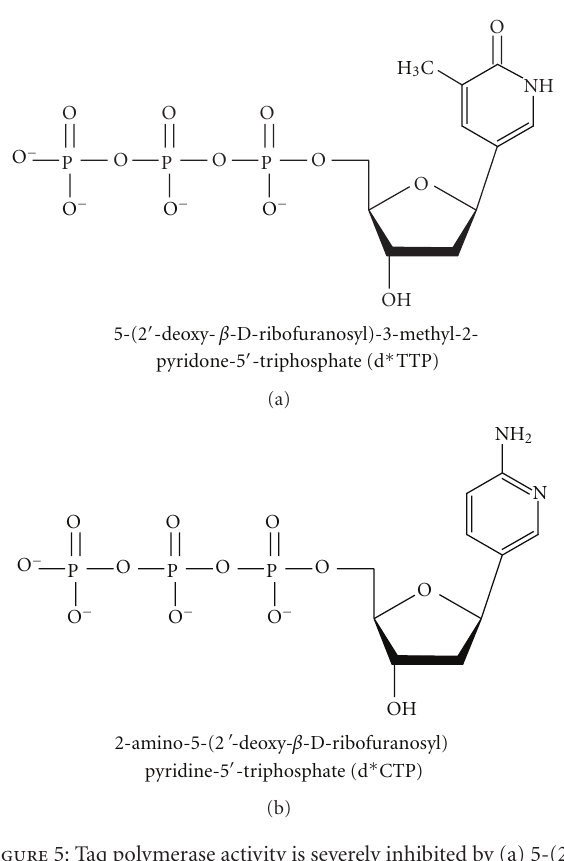
Figure 5: Taq polymerase activity is severely inhibited by (a) 5-(2 (cid:2) - Deoxy- β - D -ribofuranosyl)-3-methyl-2-pyridone-5 (cid:2) -triphosphate d ∗ TTP and (b) 2-Amino-5-(2 (cid:2) -deoxy- β - D -ribofuranosyl)pyridine- 5 (cid:2) -triphosphate (d ∗ CTP), dC, and dT analogs, respectively, lacking the 2-keto groups